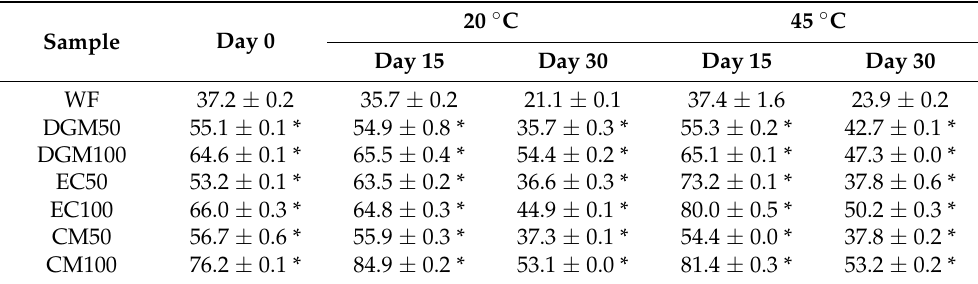
Table 4. Effect of addition of non-encapsulated (DGM), encapsulated (EC) and color-masked (CM) defatted Nannochloropsis oceanica to wheat flour (WF, control) on ferrous iron ( µ g ferrous iron/g flour) 1